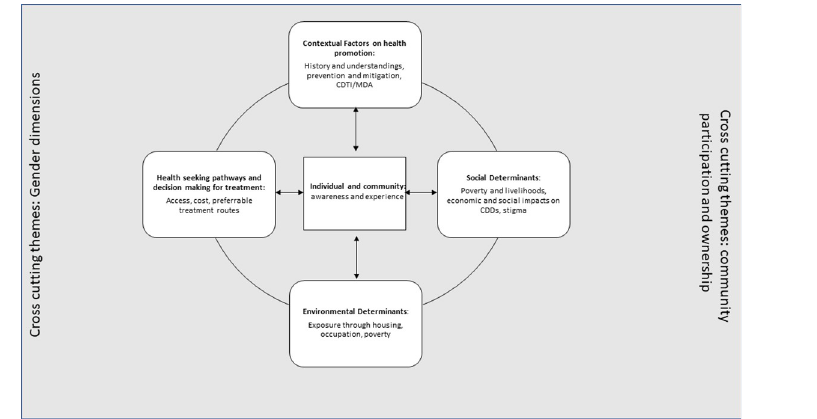
Fig 1. Social-ecological approach for Onchocerciasis